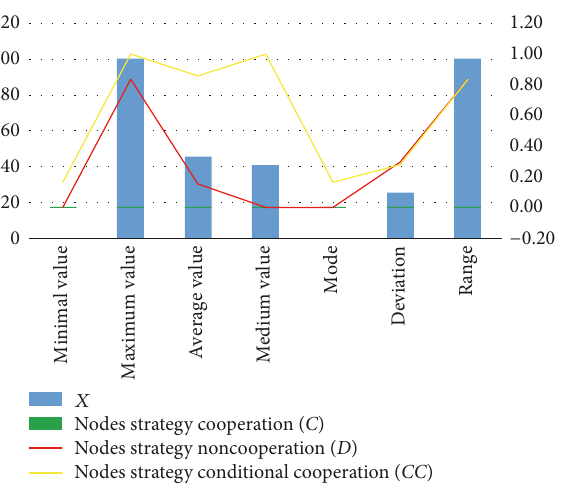
Figure 16: The state of population when 𝑋 = (0, 300, 130.2, 139.4, 0, 86.78, 300).